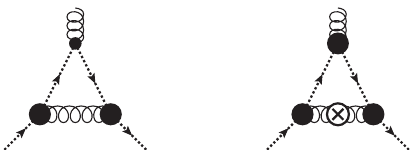
Figure 2: Typical diagrams that contribute to the ghost-gluon vertex DSE (left), [ 40 ] and FRG (right), [ 18 ] . The presence of the gapped gluon propagator ensures that the ghost-gluon vertex is constant in the infrared. It can be shown that this behavior is present at every finite truncation